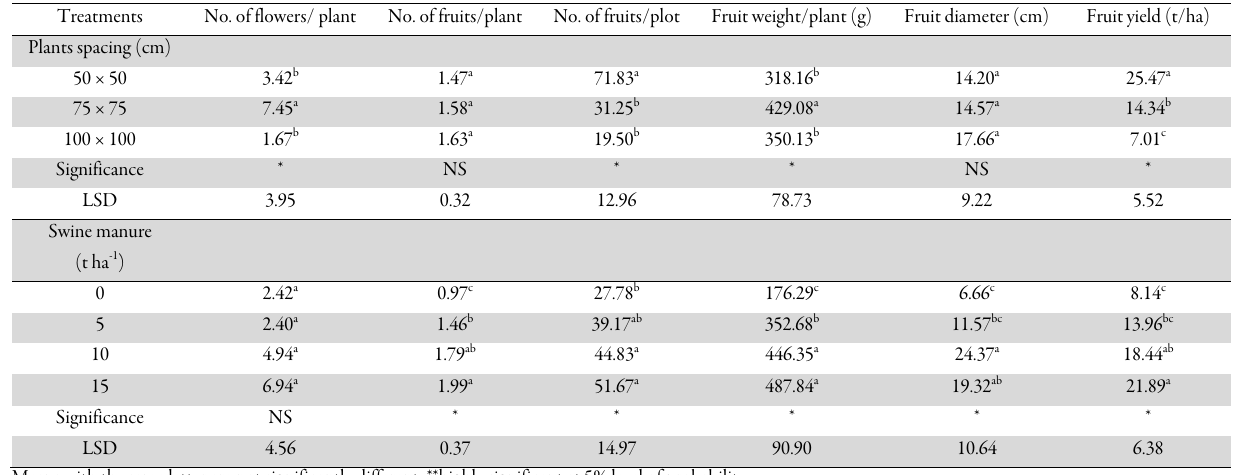
Table 3. Effect of spacing and swine manure on yield and yield components of muskmelon Treatments